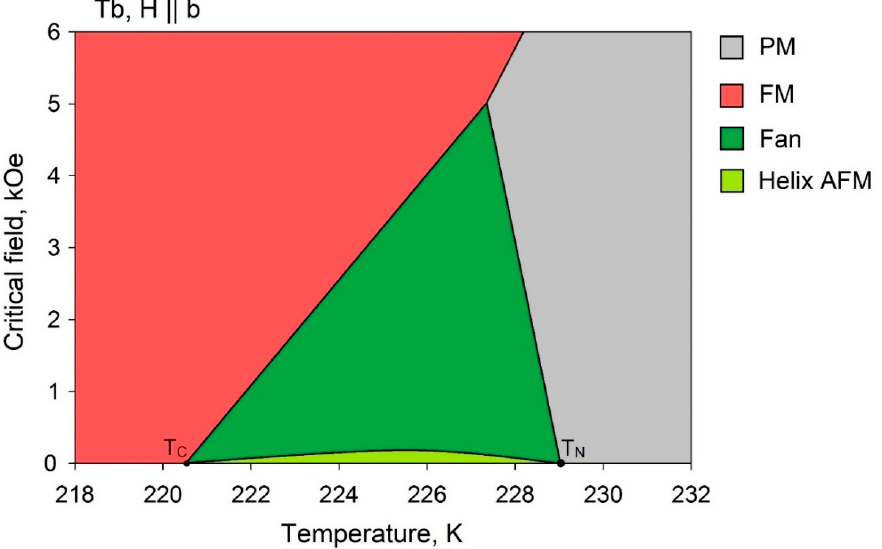
Figure 3. Magnetic phase diagram of Tb. The experimental data has been taken from